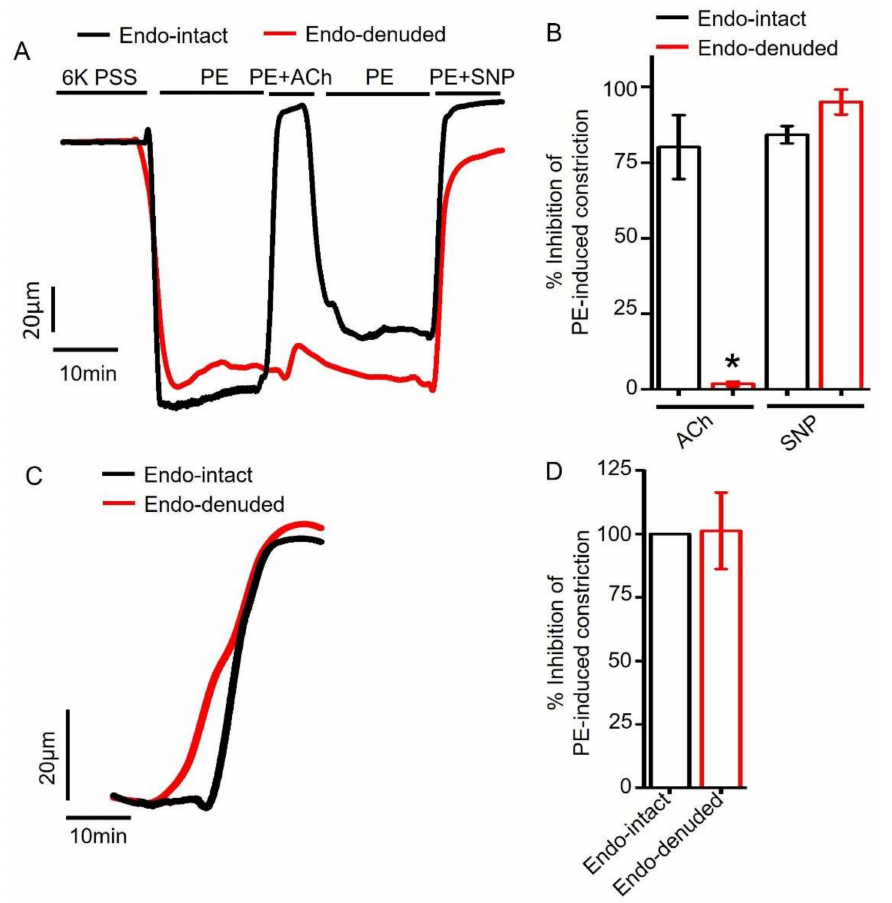
Figure 5. Empagliflozin-induced vasodilation is endothelium independent. ( A ) Original traces comparing responses of PE-constricted endothelium (endo) intact and denuded mesenteric arteries to ACh (1 µ M) and SNP (10 µ M). ( B ) Mean data showing selective loss of ACh-induced vasodilation but not SNP-elicited vasodilation in endo-denuded and PE-constricted arteries, n = 4. * p < 0.05 vs. endo-intact. ( C ) Original traces comparing Empa-induced (100 µ M) vasodilation in endo-intact and endo-denuded arteries. ( D ) Mean data comparing Empa-induced vasodilation in endo-intact and endo-denuded mesenteric arteries, n =